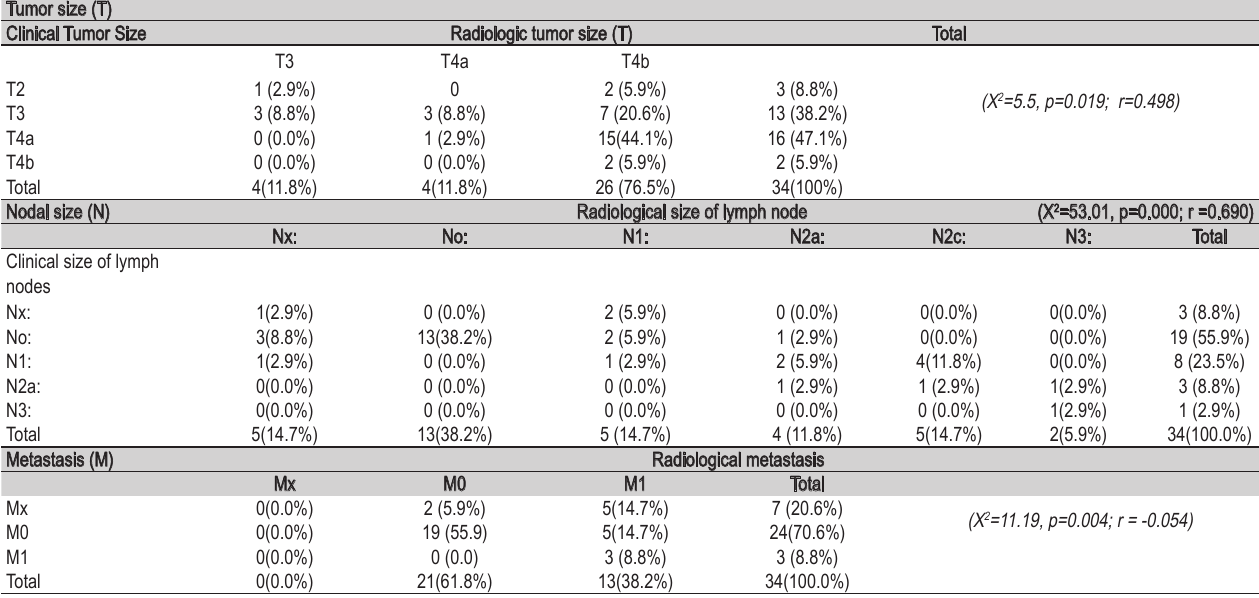
Table 2 - The relationship between clinical TNM and radiological TNM.